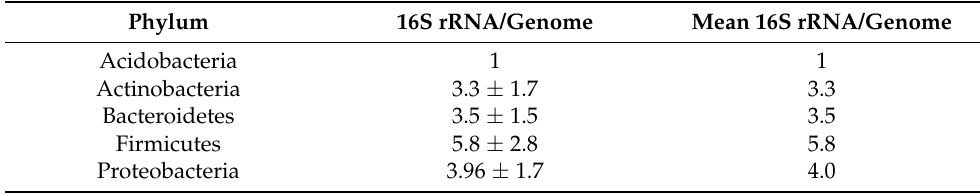
Table 5. Copy number of 16S rRNA in each bacterial genome